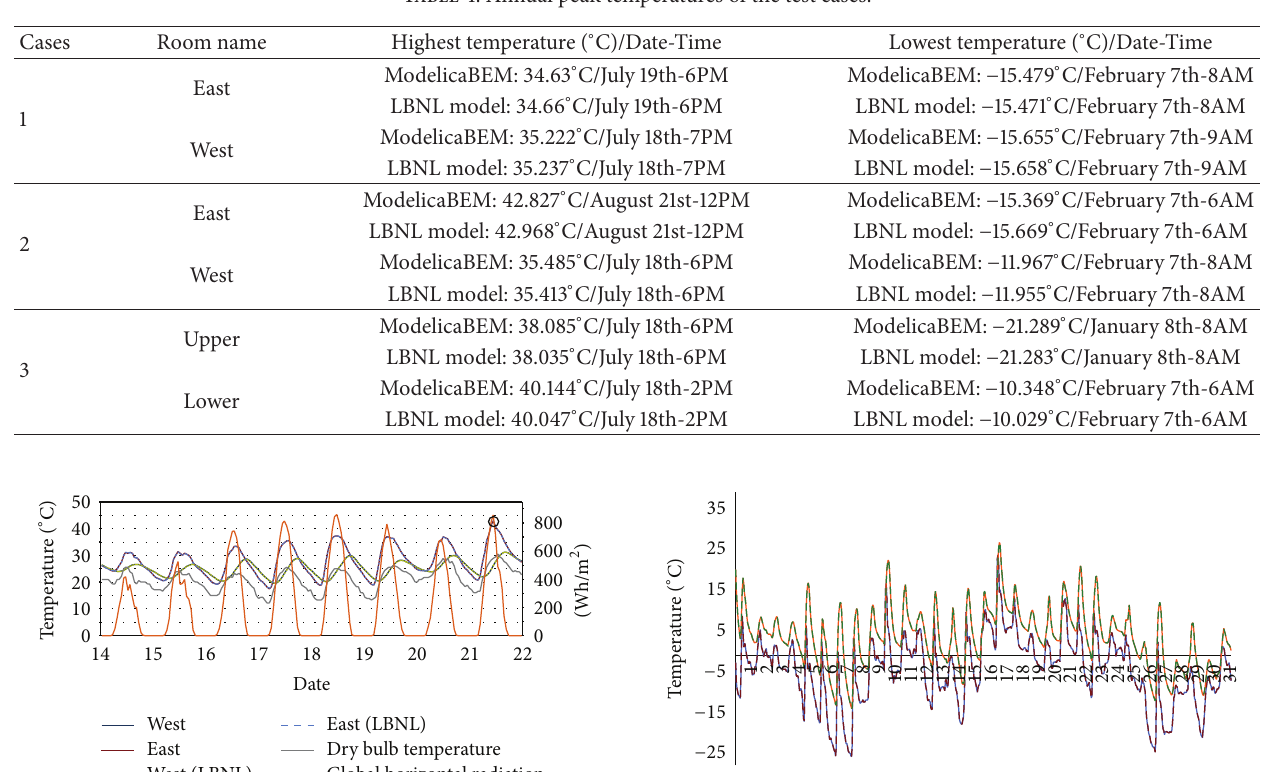
Table 4: Annual peak temperatures of the test cases.